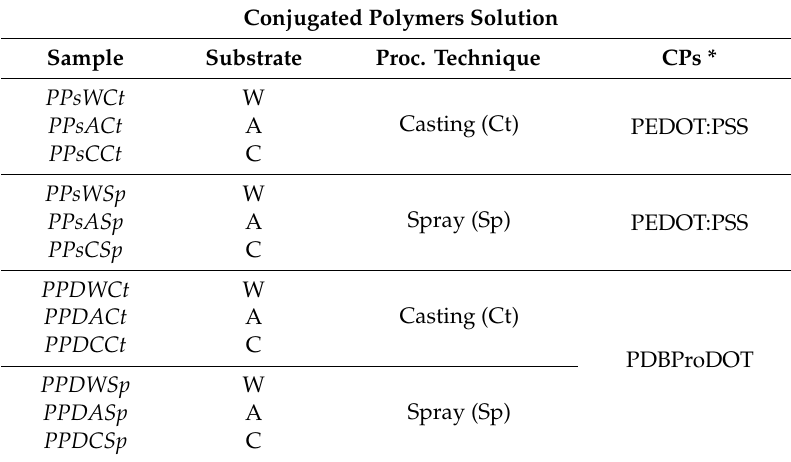
Table 2. Polythiophene-derivative/cellulose materials prepared by solution.